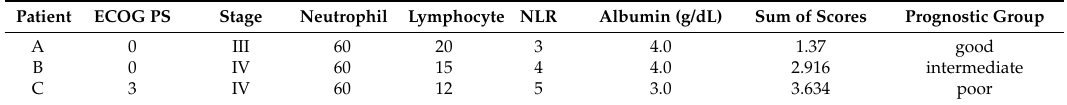
Table 5. Example of prognostic score calculation for 3 hypothetical